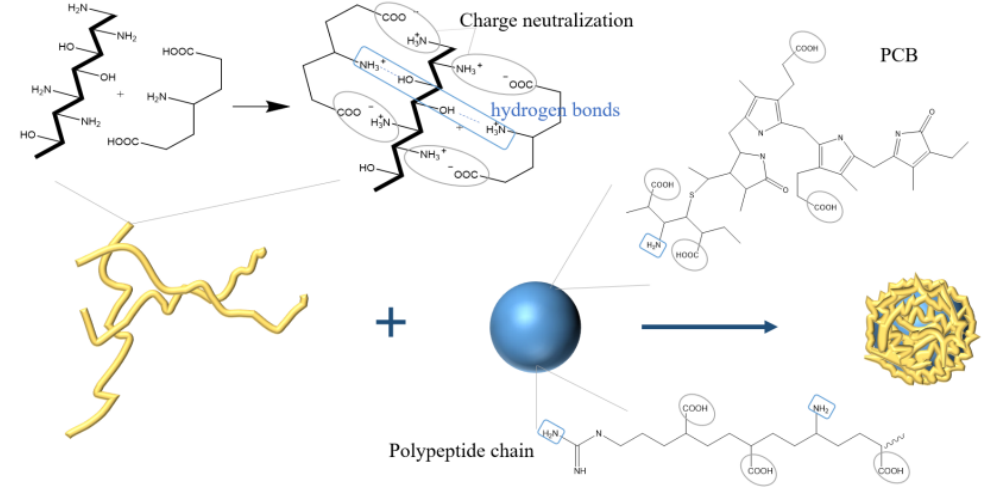
Figure 8. Schematic illustration showing the preparation of PC microcapsules using ion gelation